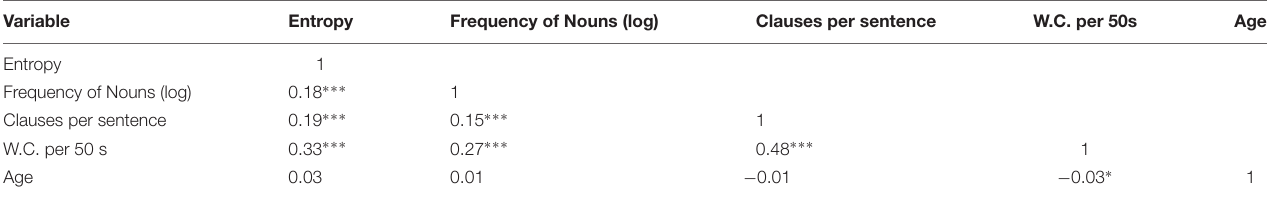
TABLE 2 | Correlation matrix for the linguistic measures and age. Variable Entropy Frequency of Nouns